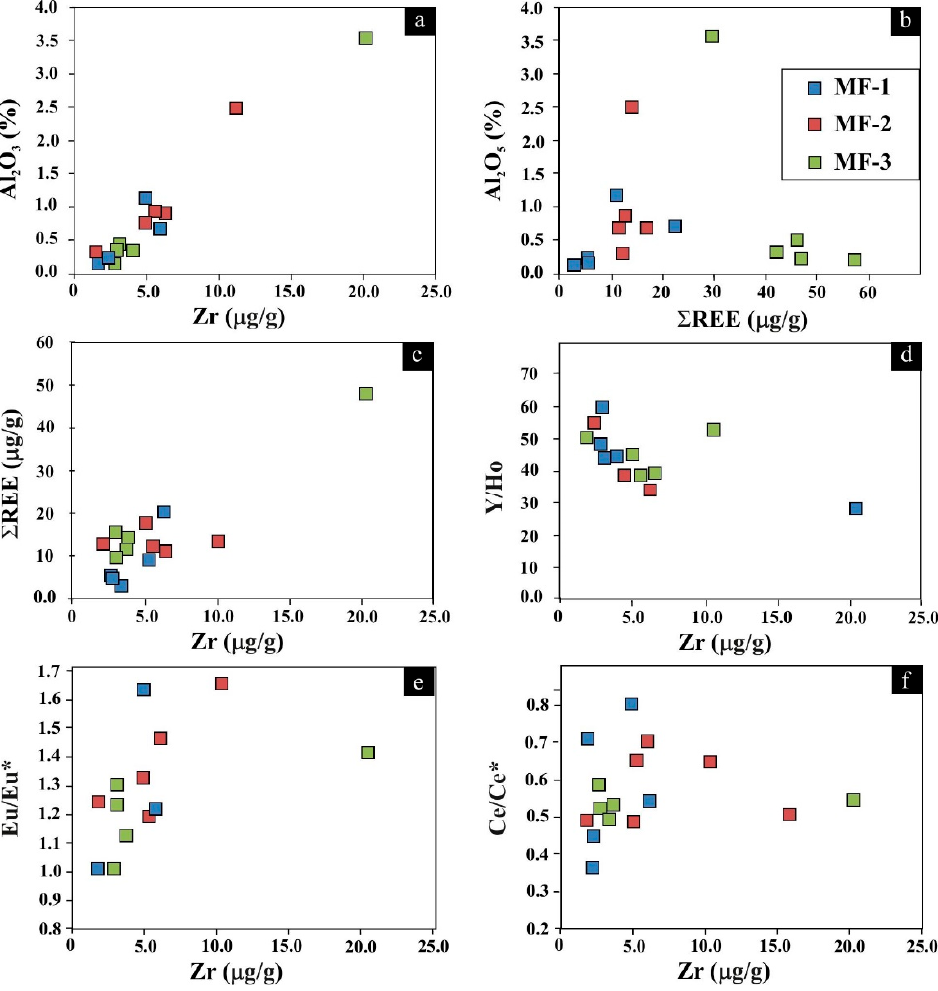
Figure 7. Plots of the Zr ( µ g / g) vs. Al 2 O 3 (wt %) contents ( a ); Σ REE ( µ g / g) vs. Al 2 O 3 (wt %) contents ( b ); Zr ( µ g / g) vs. Σ REE ( µ g / g) contents ( c ); Y / Ho ratios vs. Zr ( µ g / g) contents ( d ); Zr ( µ g / g) contents vs. Eu / Eu* ratios ( e ); Zr ( µ g / g) contents vs. Ce / Ce* ratios ( f ).